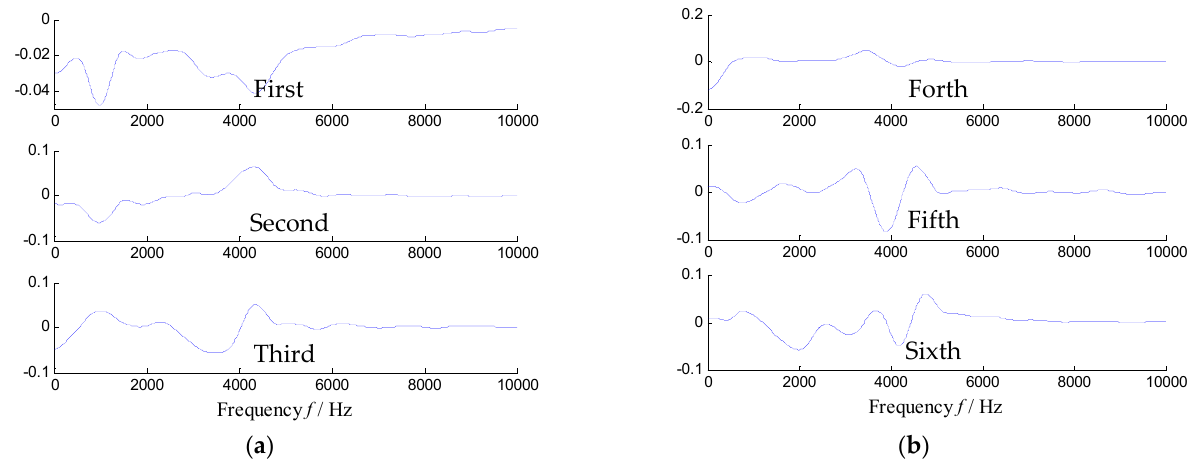
Figure 14. First six eigenvectors of Figure 4 extracted by SVD: ( a ) the first three eigenvectors and ( b ) the fourth–sixth eigenvectors.